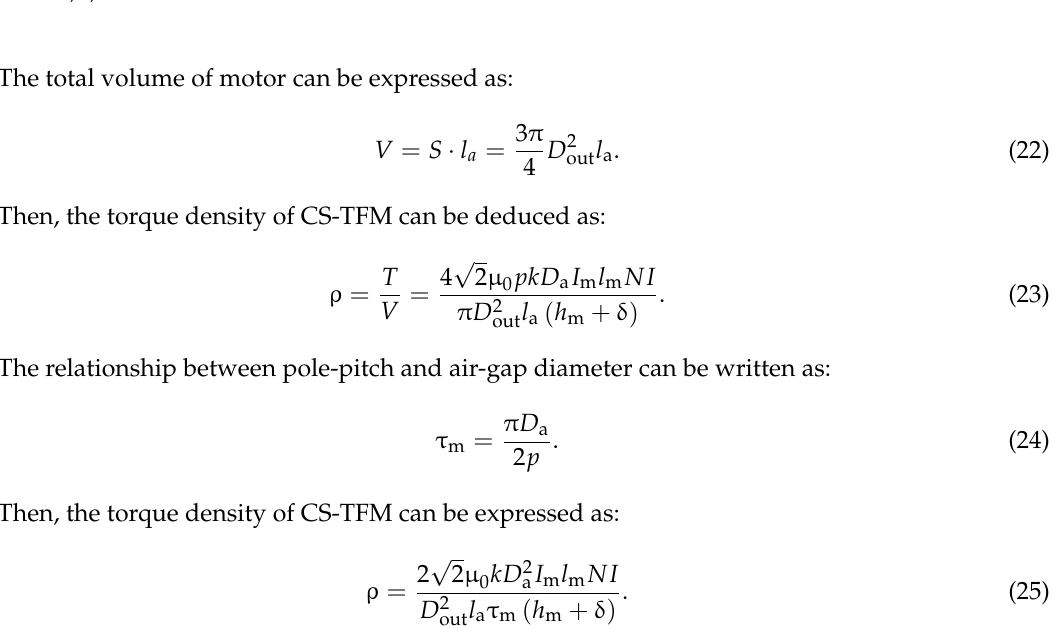
m on average torque and torque